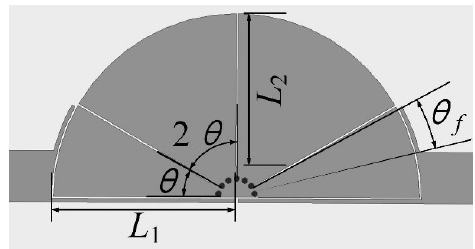
Figure 9. Structure of the filter.